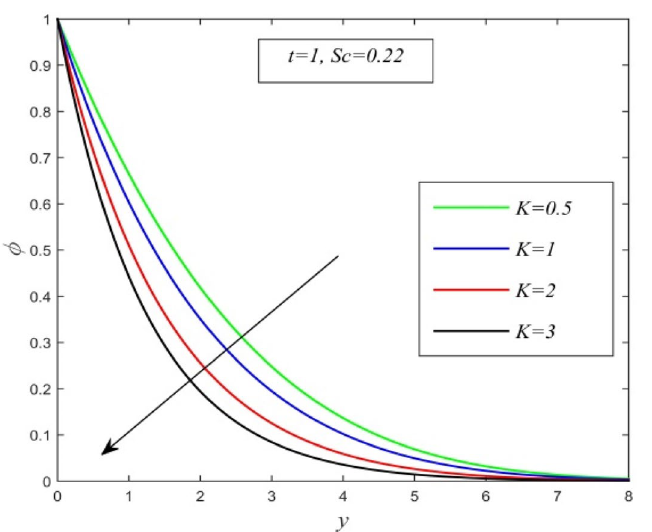
Figure 3. φ versus y for different K and t = 1, Sc =